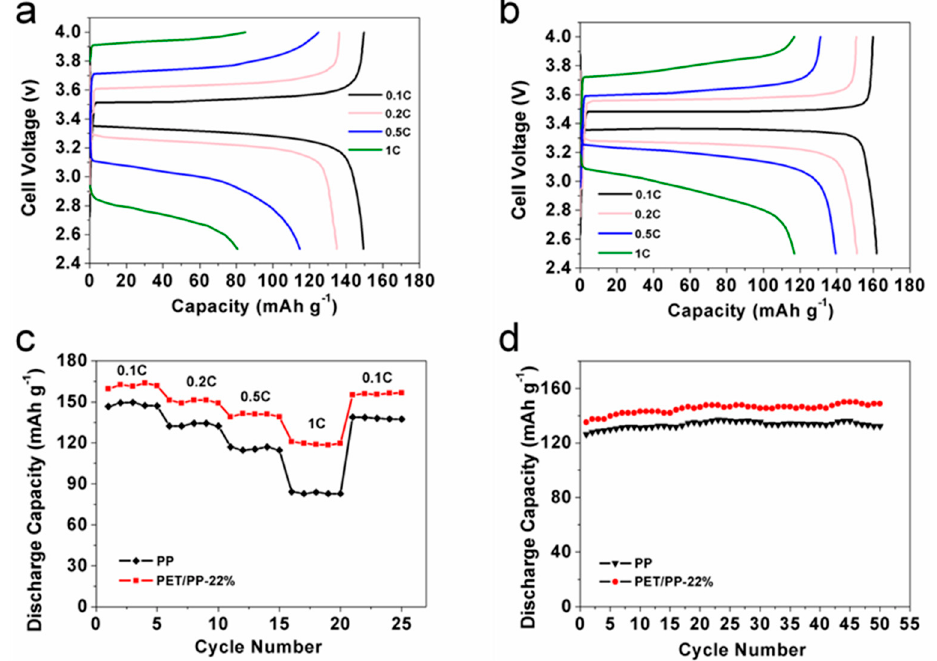
Figure 11. Charge and discharge profiles of cells assembled ( a ) PP and ( b ) PET/PP-22%; ( c ) rate capability of the cells with PP separator and PET/PP-22% at different C-rates (LE, 2.5–4.0 V); ( d ) Cycle performance of cells with PP separator and PET/PP-22%.